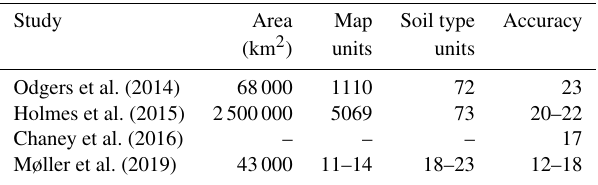
Table 4. Comparison between the size areas covered, number of soil map units, soil type units of the original legacy soil maps and the accuracy achieved in other studies using DSMART